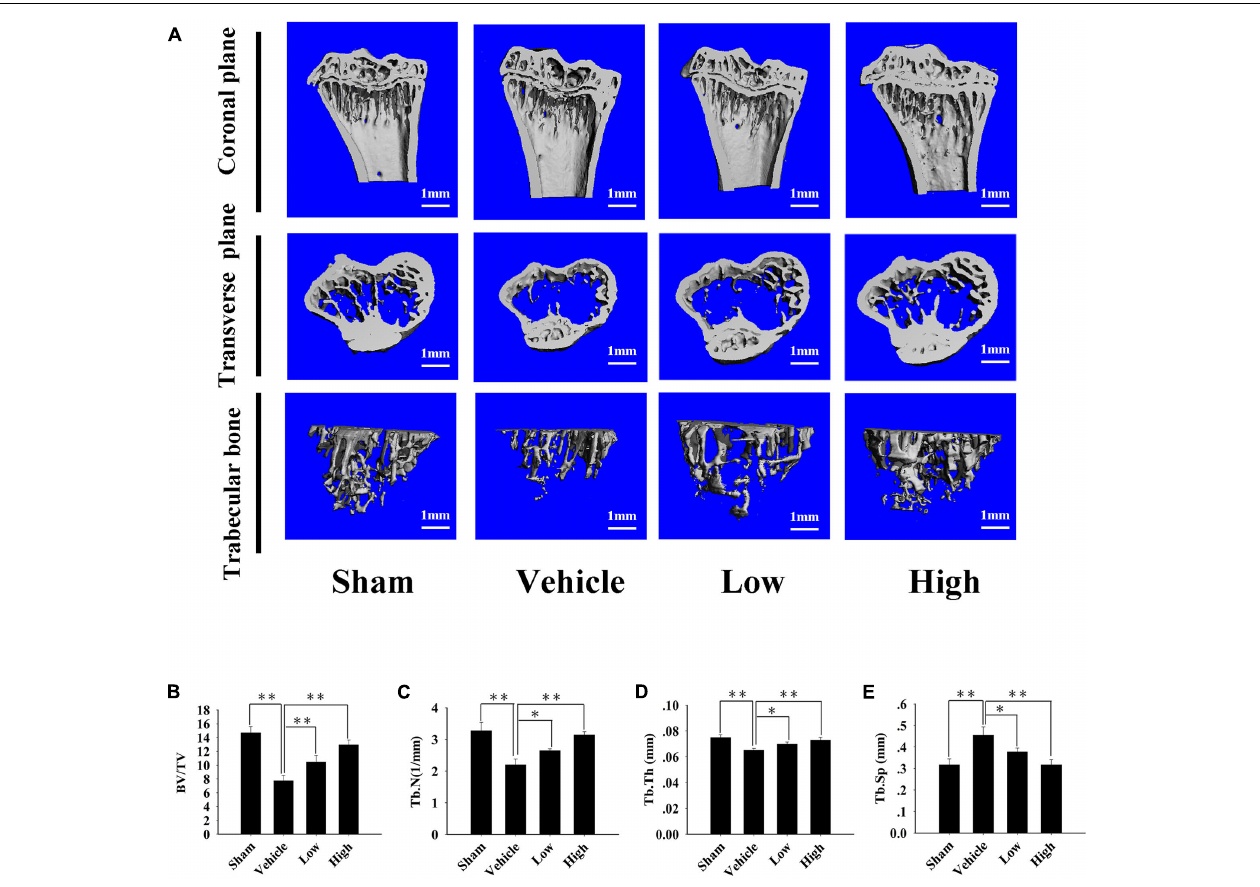
FIGURE 5 | Pra-C prevents ovariectomized (OVX) mouse bone loss. (A) Right tibias of all mice were harvested and subjected to a high-resolution Micro-CT scanning. Representative three-dimensional (3D) reconstructed images are shown. Severe bone loss was observed in vehicle-treated OVX mice. Compared to that of the vehicle-treated group, bone mass was increased in both Pra-C-treated groups. (B–E) Bone volume to tissue volume (BV/TV, %), trabecular number (Tb.N, 1/mm), trabecular thickness (Tb.Th, mm), and the trabecular separation (Tb.Sp, mm) of each sample were measured and analyzed. All plotted data are the means ± SE ( n = 5). ∗ P < 0.05; ∗∗ P < 0.01 compared to vehicle